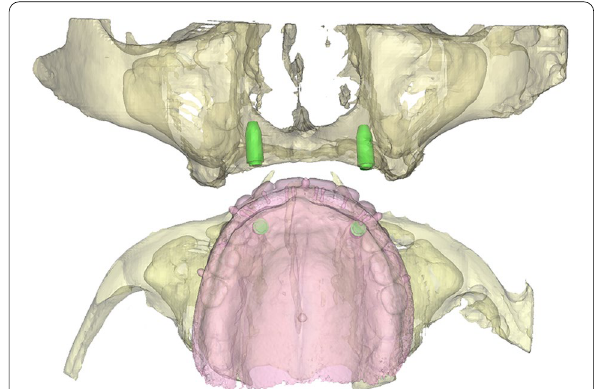
Fig. 1 3D planning of the implant